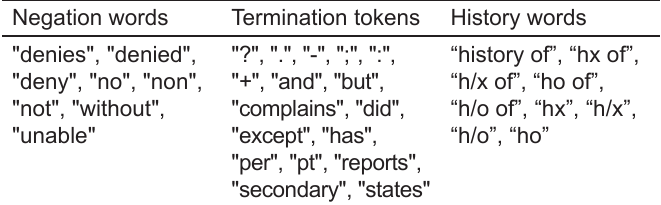
Table 3. Negation words, terminations tokens, and history words for a natural language processing algorithm to identify cases of intimate partner violence in an emergency department